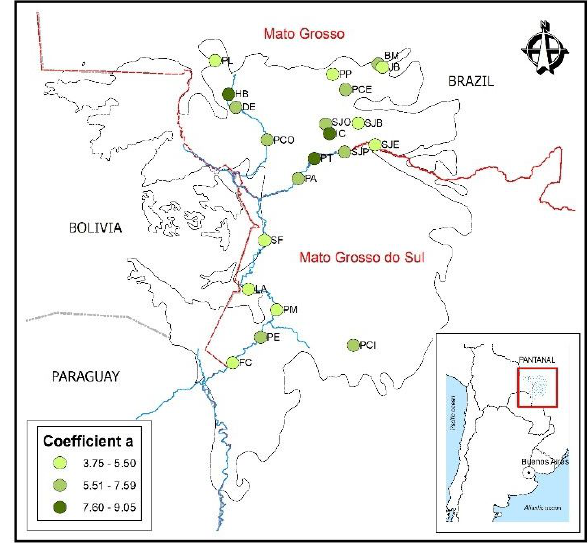
Fig. 7. Spatial distribution of the coefficient a of the regression line at the Pantanal.